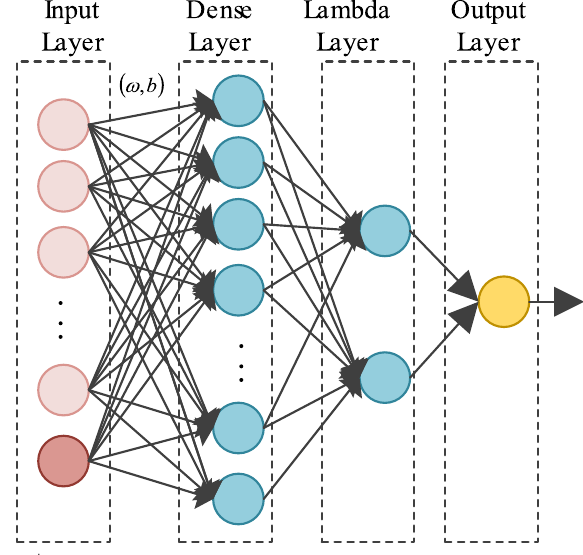
Fig. 3 Neural network structure